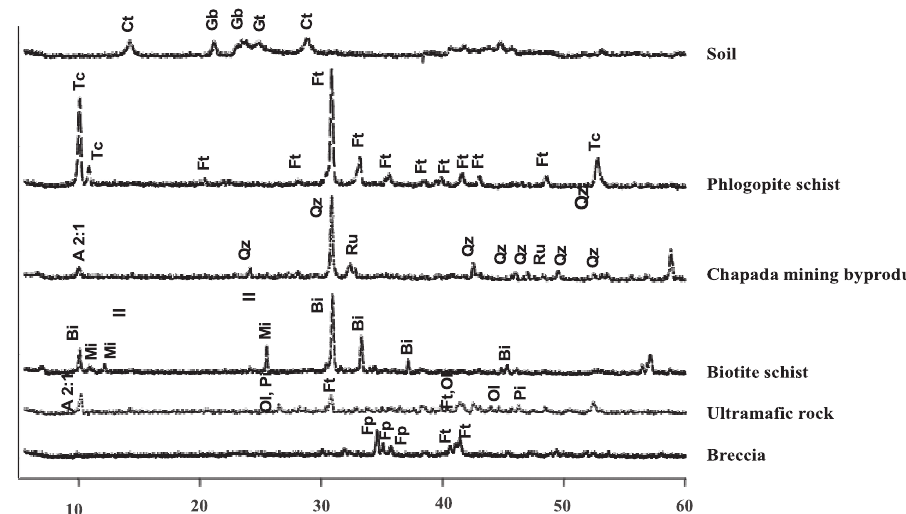
figure 3. X-ray diffractograms of soil and ground rocks, utilized as fertilizers. Ct: kaolinite; gb: gibbsite; gt: goethite; tc: talc; ft: Phlogopite schist; a 2:1: Clay-mineral 2:1; Qz: Quartz; ru: rutile; Bi: Biotite; il:illite; ol: olivine; Pi: Pyroxene; fp: feldspar.